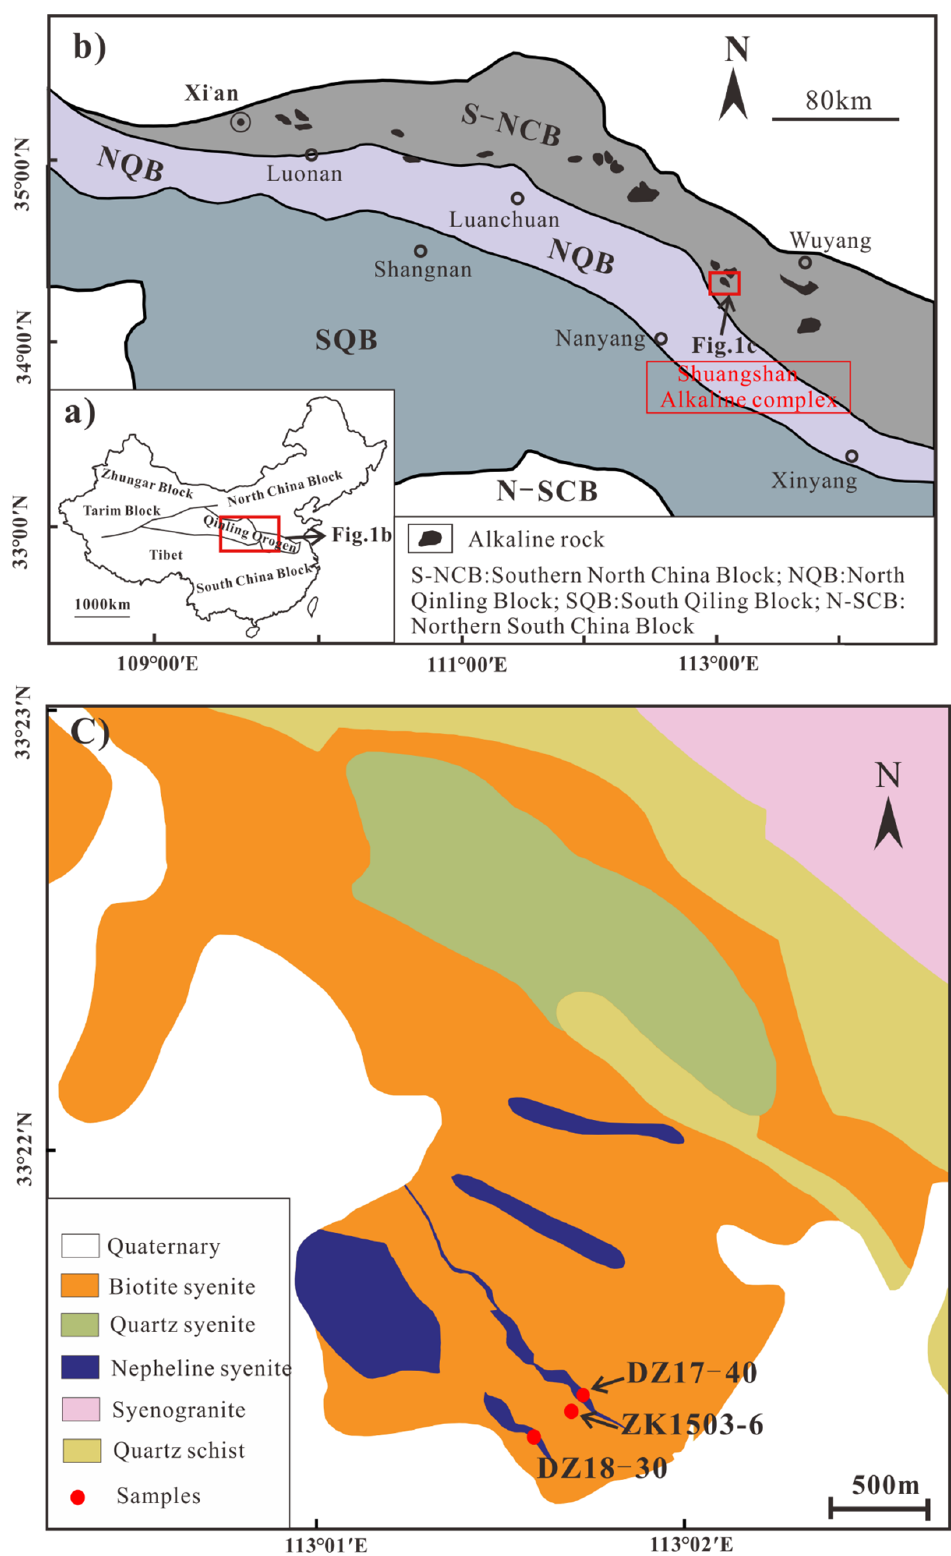
Figure 1. ( a ) Location of the Qinling Orogenic Belt. ( b ) A geological sketch map of the Qinling Orogenic Belt and distribution of alkaline rocks in the NCB (modified after Zhang et al., 2002) [20]; ( c ) A geological map of the Shuangshan alkaline complex, showing the distribution of the principal rock types and the location of the samples.